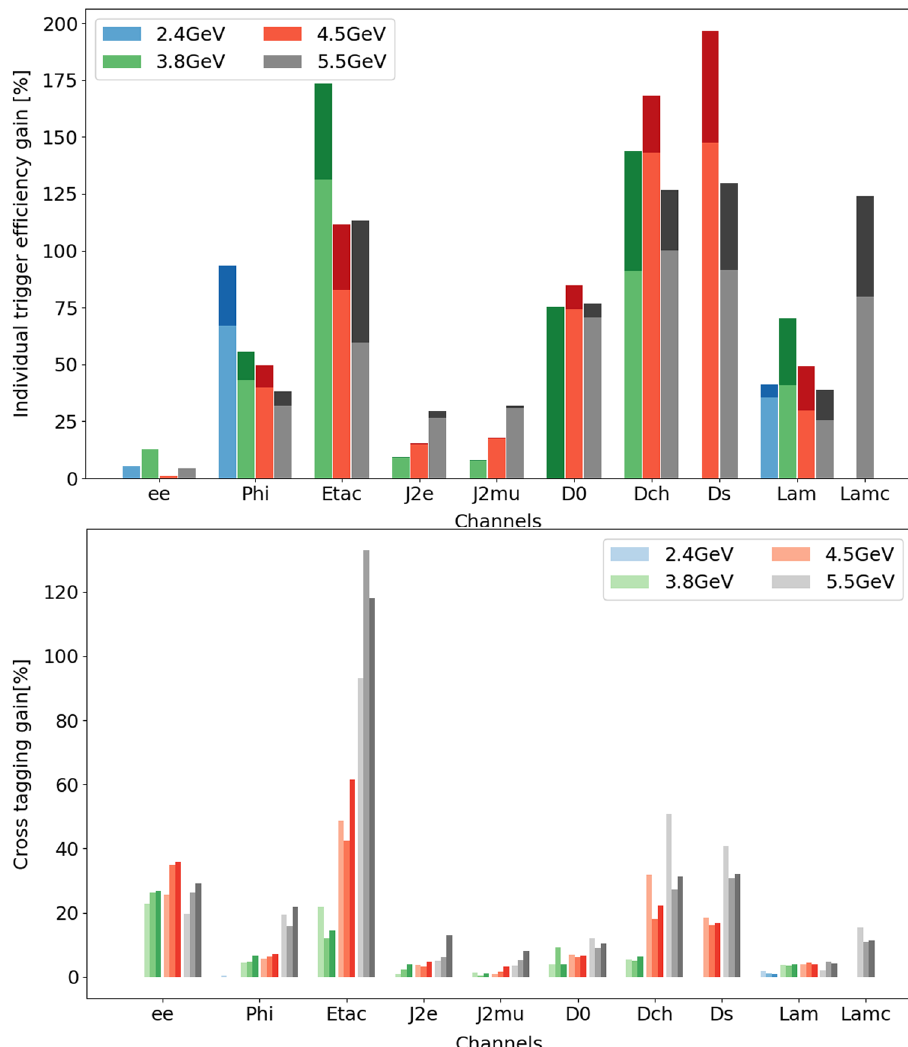
Fig. 6 Individual triggering efficiency gains of the neural networks compared to the conventional approach, based on the same set of input observables (light colours), and on the extended set of observables (dark